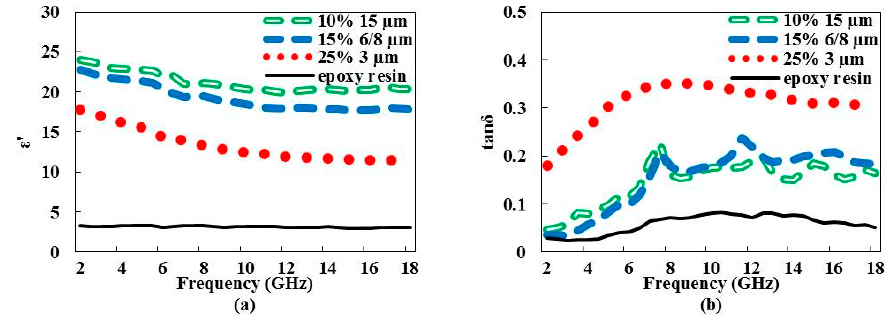
Figure 4. Variation of dielectric constant ε ’ ( a ) and loss tangent tan δ ( b ) vs. frequency of epoxy resin loaded with the maximum weight ratio of the related graphene particle sizes. Pristine epoxy resin values are given for reference.